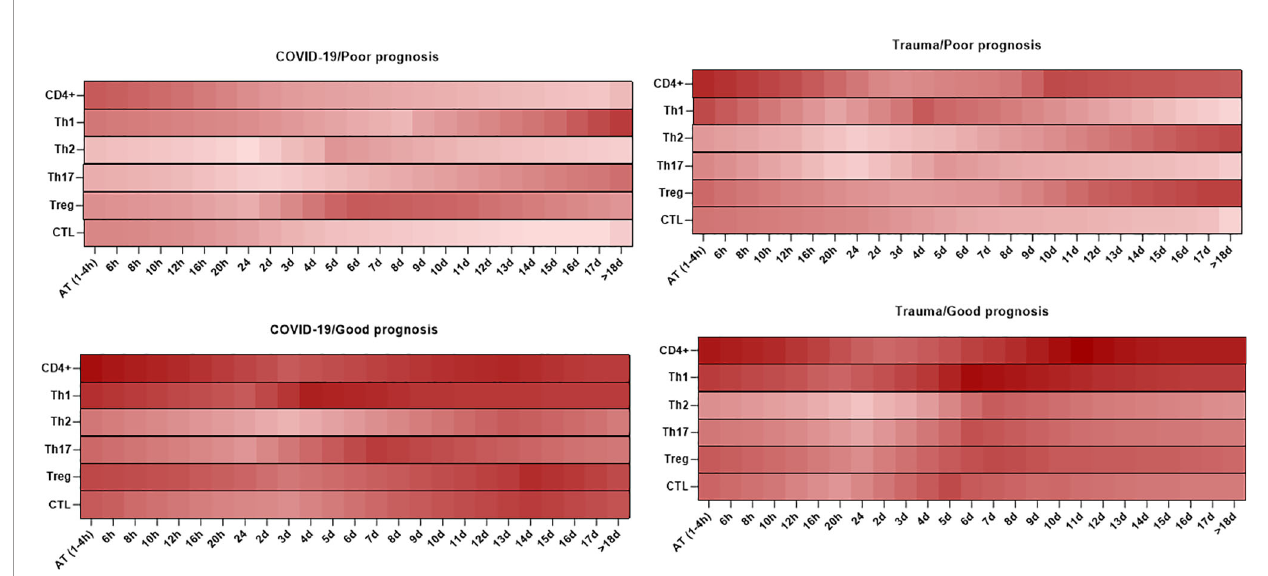
FIGURE 4 | Association between the kinetics of changes in circulating CD4+ and CD8+ T cell subsets with prognosis in patients with COVID-19 and trauma. The heat map shows the kinetics of changes in CD4+ T cells (167, 170, 211, 213), Th1 (214, 215), Th2 (214, 215), Th17 (214, 215), Treg (214, 215), and CTL (30, 170, 213, 216 – 218) counts during 18 days after admission in COVID-19 and trauma patients associated with poor and good prognoses. COVID-19 patients with an increased risk of mortality, MOF, severe-to-critical forms of the disease, intensive care unit admission, and/or hospitalization are de fi ned as a poor prognosis for the disease. Conversely, patients with the opposite are de fi ned as having a good prognosis for the COVID-19. AT, admission time; CTL, cytotoxic T cell; d, day; h, hour; Th, helper T cell; MOF, multiple organ failure; Treg, regulatory T